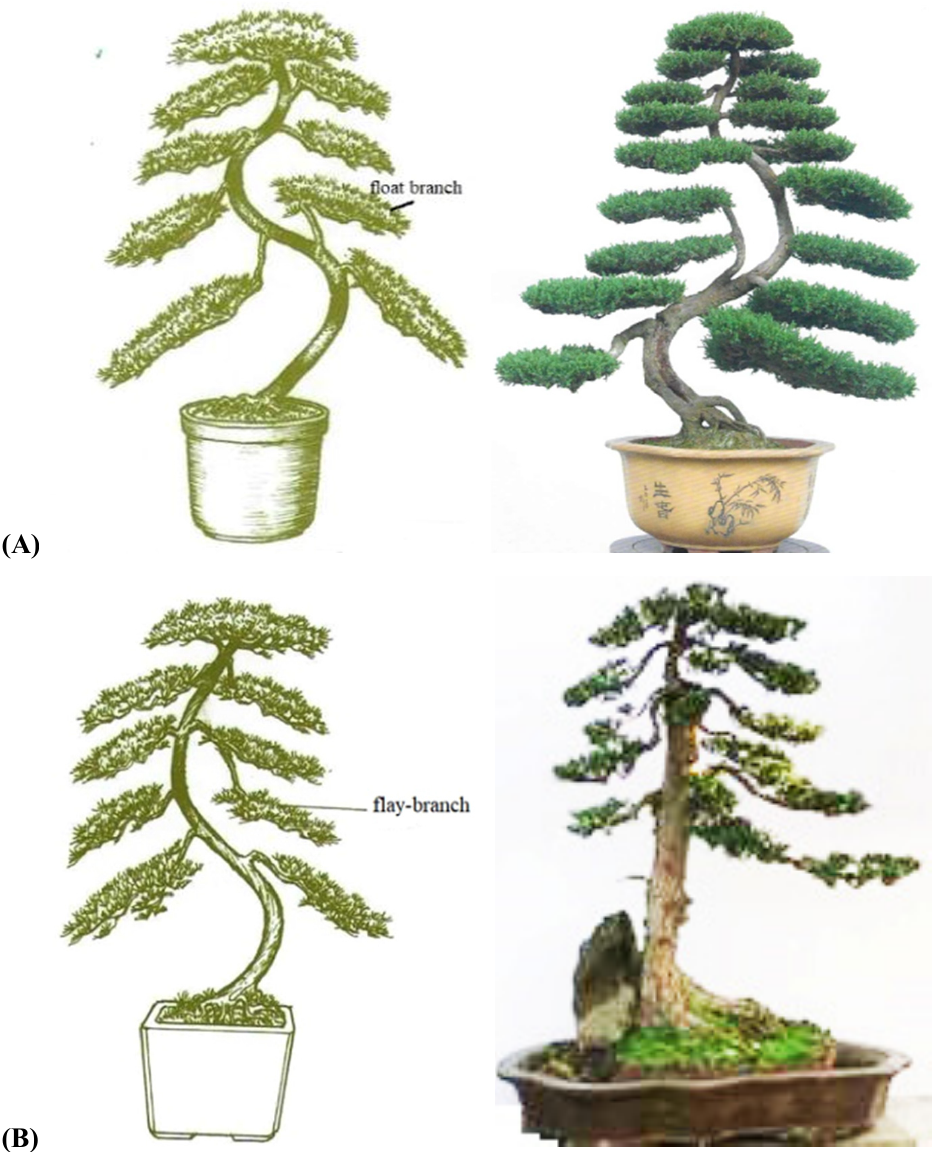
Figure 6. The traditional float ( A ) and flay ( B ) branch styles.